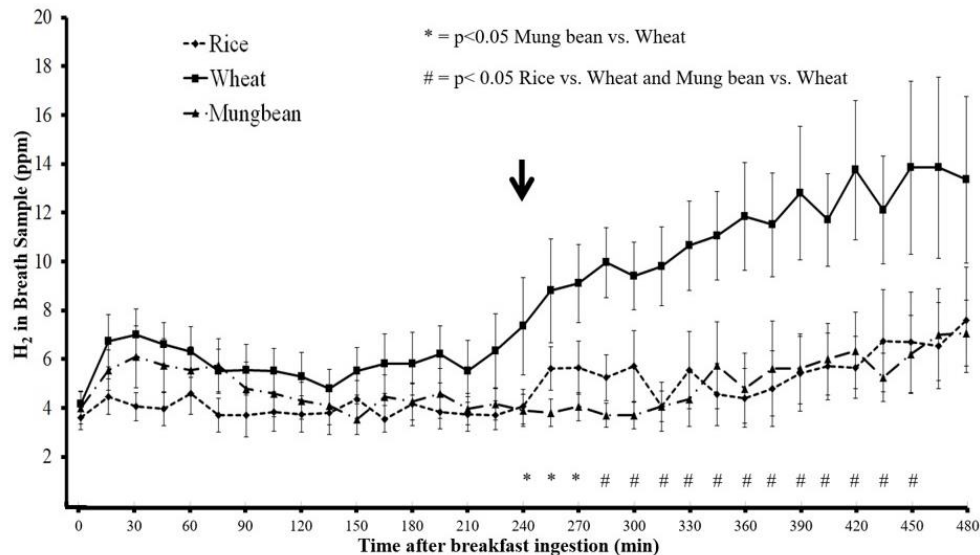
Figure 1. Intestinal hydrogen (H 2 ) gas levels (mean ± SEM, ppm) measured from breath samples in non-constipation irritable bowel syndrome (non-C IBS) patients after ingestion of rice, wheat, and mung bean noodle (arrow = time of lunch ingestion).